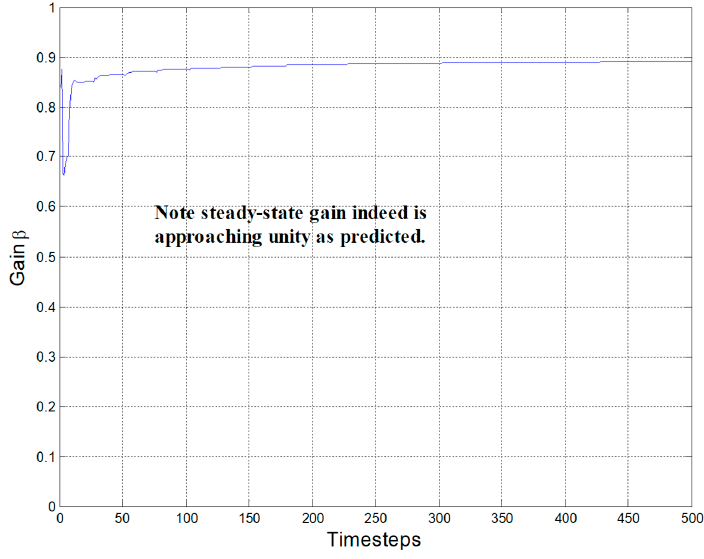
Figure 5 . Steady-state gain β of indirect self-tuner (without zero cancellation) of minimum phase system.